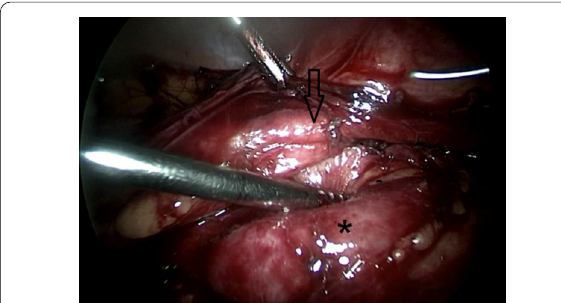
Fig. 3 Malrotated right kidney (black star). The arrow shows the anteriorly oriented renal pelvis and ureter